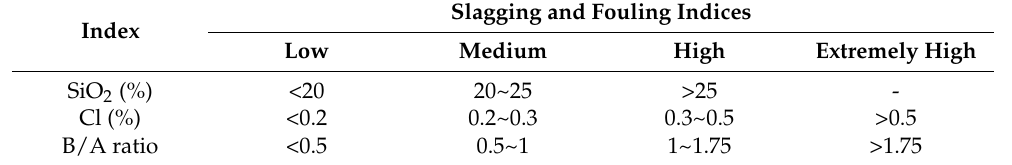
Table 3. Slagging and fouling